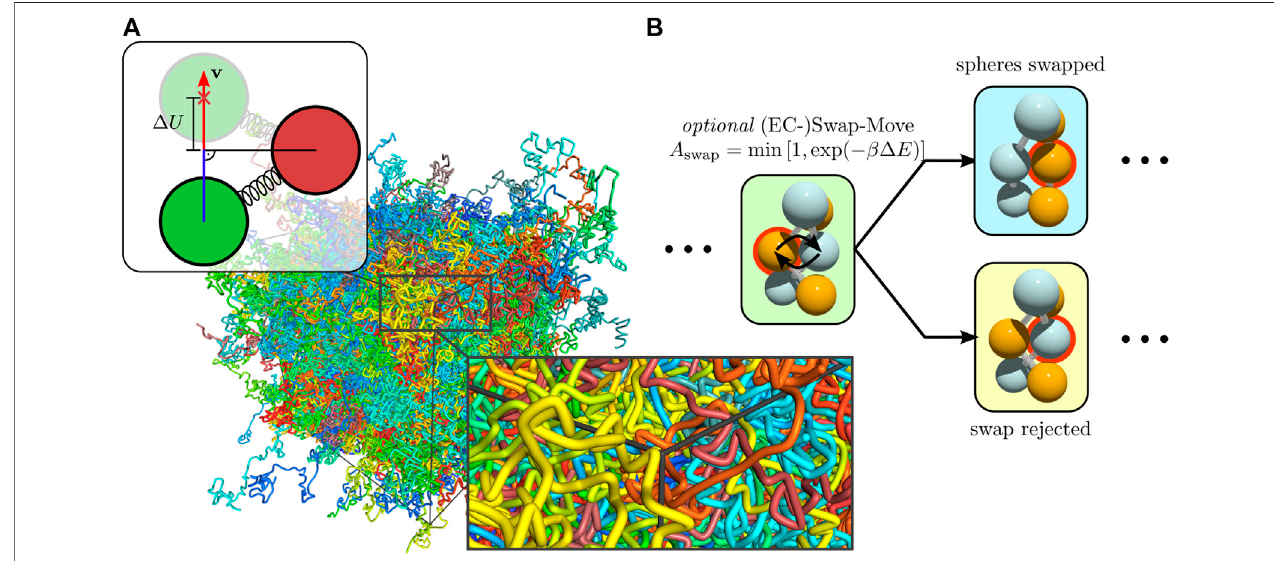
FIGURE 6 | The background shows a polymer melt of fl exible chains, which are presented as volumetric splines (A) Scheme for the rejection distance for hard spherechains.Iftwobonded spheresdo not collide, the active spherecanmove freelyuntil the minimaldistancebetweenboth isreached. A usable energy Δ E isdrawn (see Figure 4 ) which determines where the rejection takes place (B) Scheme of a swap move. In case of a hard sphere collision, the energy difference of each involved springsiscalculatedwhenthebeads wouldswitchpositions.Theswapmoveisaccepted withastandardMetropolis fi lter,otherwisetheECiscontinuednormally. The active particle is marked by a red